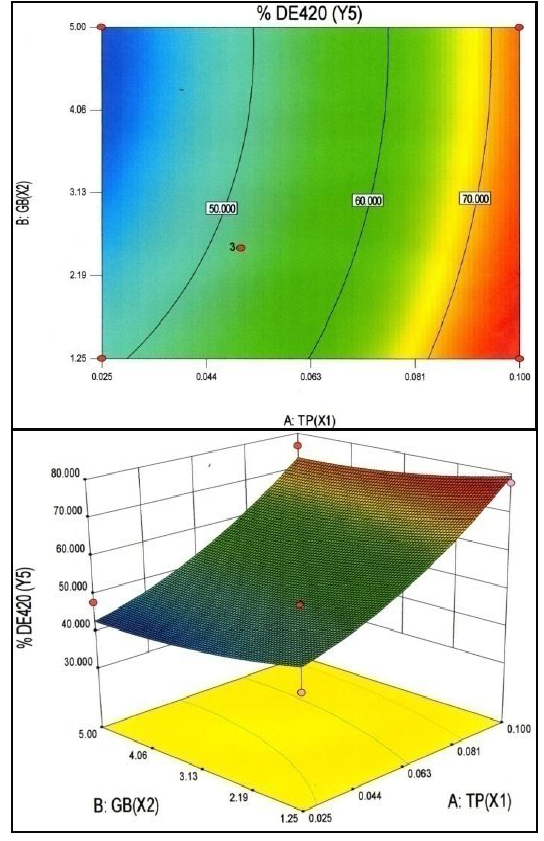
Figure 9: Response surface contour plot (Up) and 3D plot (down) for TP and GB effect on %DE